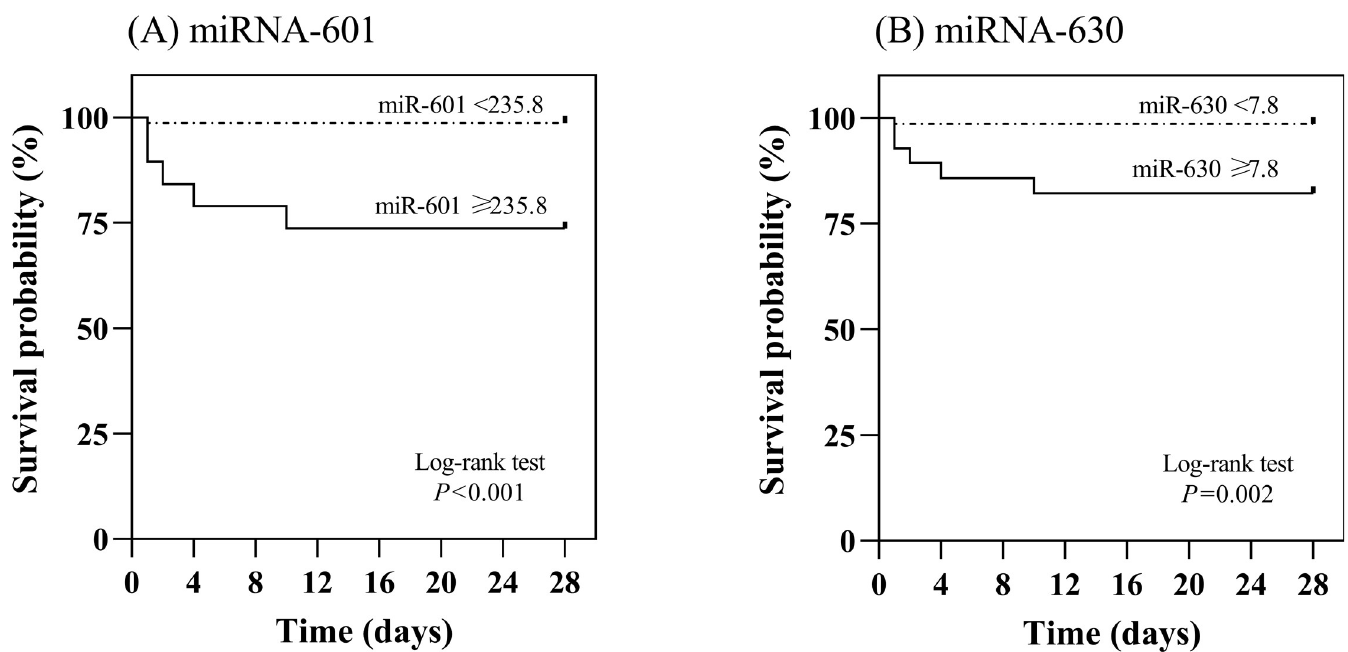
Fig 4. Overall survival analysis of miR-601 (A) and miR-630 (B) in patients with